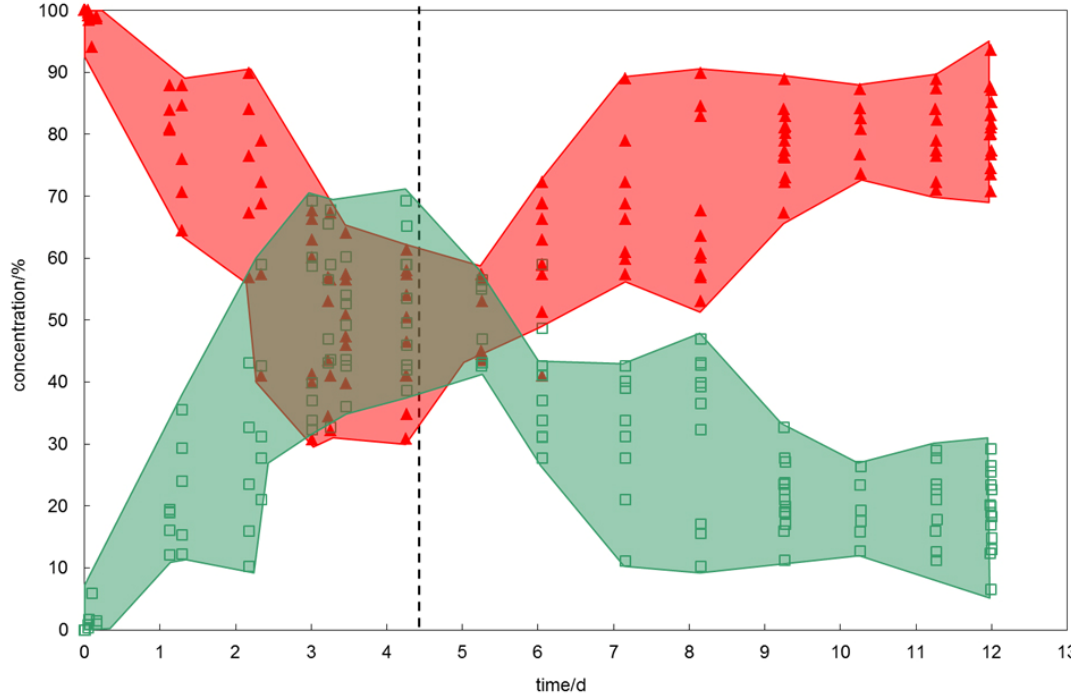
Figure 2. ( a ) Changes in hydrate composition (red—CH , green—CO ) with time when 4 2 CH hydrate is exposed to CO and vice versa . The red and green areas emphasize the 4 2 heterogeneity of the hydrate phase. At the starting point (time zero) the prepared CH 4 hydrate was exposed to exchange gas, the dashed line marks the time when the gas composition has been changed back to the initial hydrate forming gas. ( b ) Changes in , green—CO , small green diamonds—SO ) with time hydrate composition (red—CH 4 2 2 hydrate is exposed to CO -SO gas and vice versa . ( c ) Changes in hydrate when CH 4 2 2 composition (red—CH , small red circles—C H , green—CO ) with time when CH -C H 4 2 6 2 4 2 6 hydrate is exposed to CO gas and vice versa . ( d ) Changes in hydrate composition 2 , small red circles—C H , small green diamonds—CO , plus—SO ) with time (red—CH 4 2 6 2 2 when CH -C H hydrate is exposed to CO -SO gas and vice versa 4 2 6 2 2